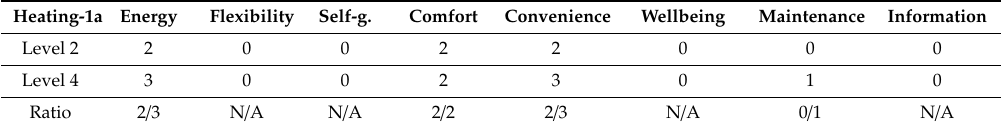
Table 1. The impacts of heating-1a and the ratio, when the service has been implemented on functionality level 2 in a